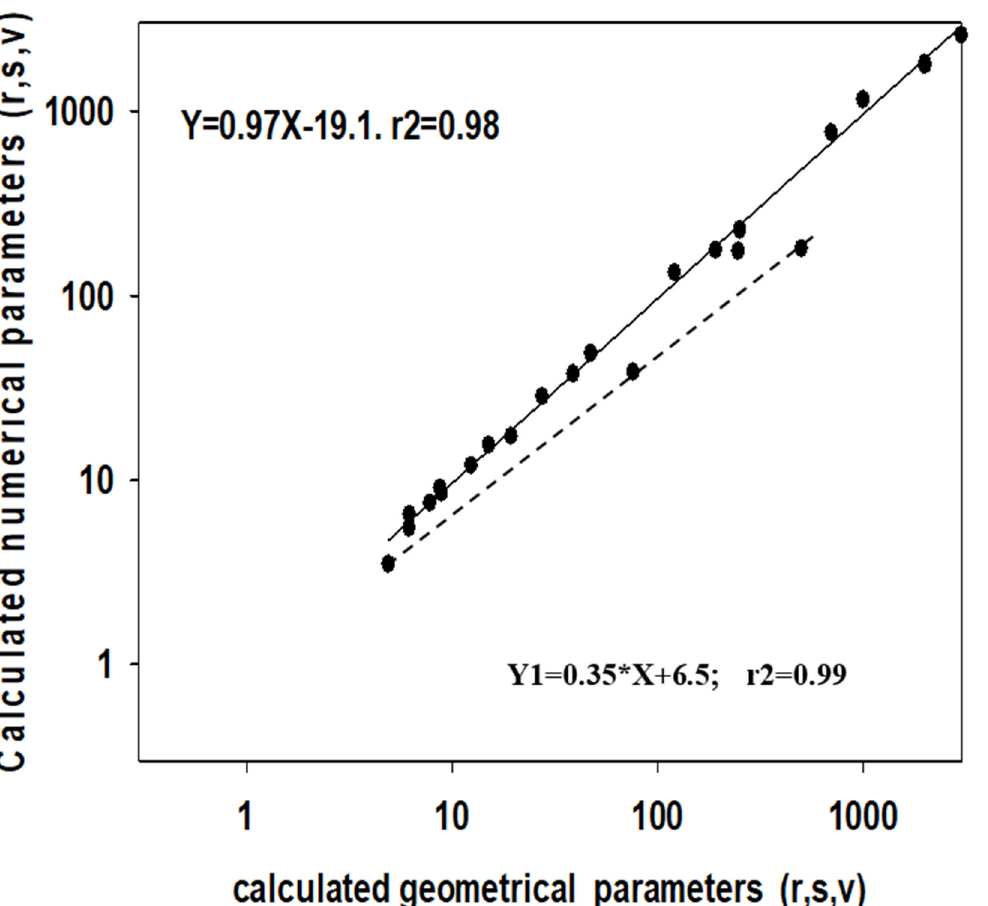
Figure 7. Regression line between geometrical/radial and numerical determination of three radial- dependent drip infiltration parameters, including radius ( r ), projection of surface area (s) and water volume (v). Data are specified in Table 3 for DI and in Table 4 for SDI. The three points connected by the dashed line belong to the lowest discharge (500 cm 3 ). The regression equation on top of Figure 6 hr includes all available data points (including the lower points), while the regression below includes only the three lowest